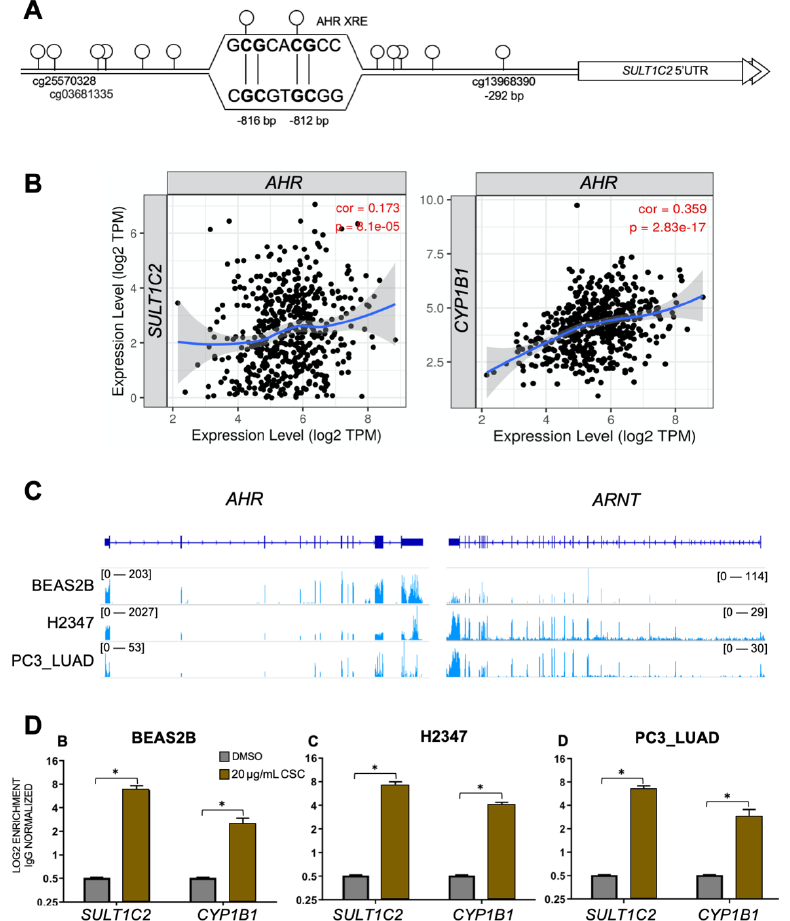
Figure 5. CSC alters AHR occupancy at the SULT1C2 promoter. ( A ) Diagram of the SULT1C2 promoter including CpG at cg13968390, including the predicted AHR binding site. Open circles indicate CpG dinucleotides within the 1.8kb promoter region. Coordinates listed are relative to the transcriptional start site of SULT1C2 . ( B ) Scatterplot of expression for indicated genes. Data included were derived from the TCGA LUAD dataset and visualized using TIMER2.0 [40]. Cor = correlation between expression of the indicated genes. ( C ) IGV browser image of AHR and ARNT genomic regions. RNAseq (blue) was downloaded from publicly available resources [32,33]. ( D ) The indicated cell lines were treated with 20 µ g/mL CSC for 72 hrs. ChIP was performed with AHR antibody. Gray = AHR bound to promoter when DMSO treated, Brown = AHR enrichment on SULT1C2 promoter when treated with 20 µ g/mL CSC for 24 h. Normal rabbit IgG was used to correct for background binding levels. (*) = p ≤